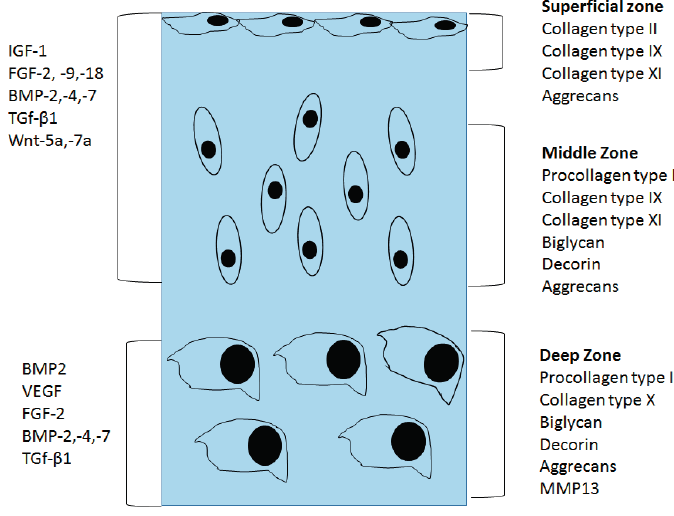
Figure 1. Organization of normal articular cartilage. Superficial, middle, and deep zones and their extracellular matrix is divided using different sections. Growth factors that control the chondrocyte function are divided based on the stage of chondrocyte